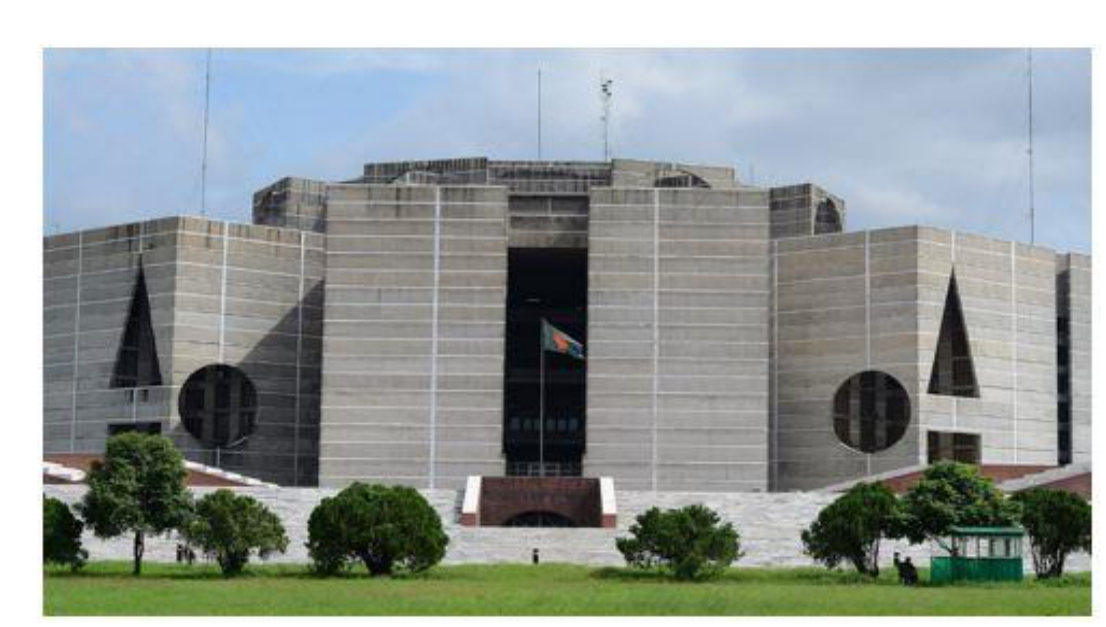
Figure 3. National Parliament House with exterior view [Source: